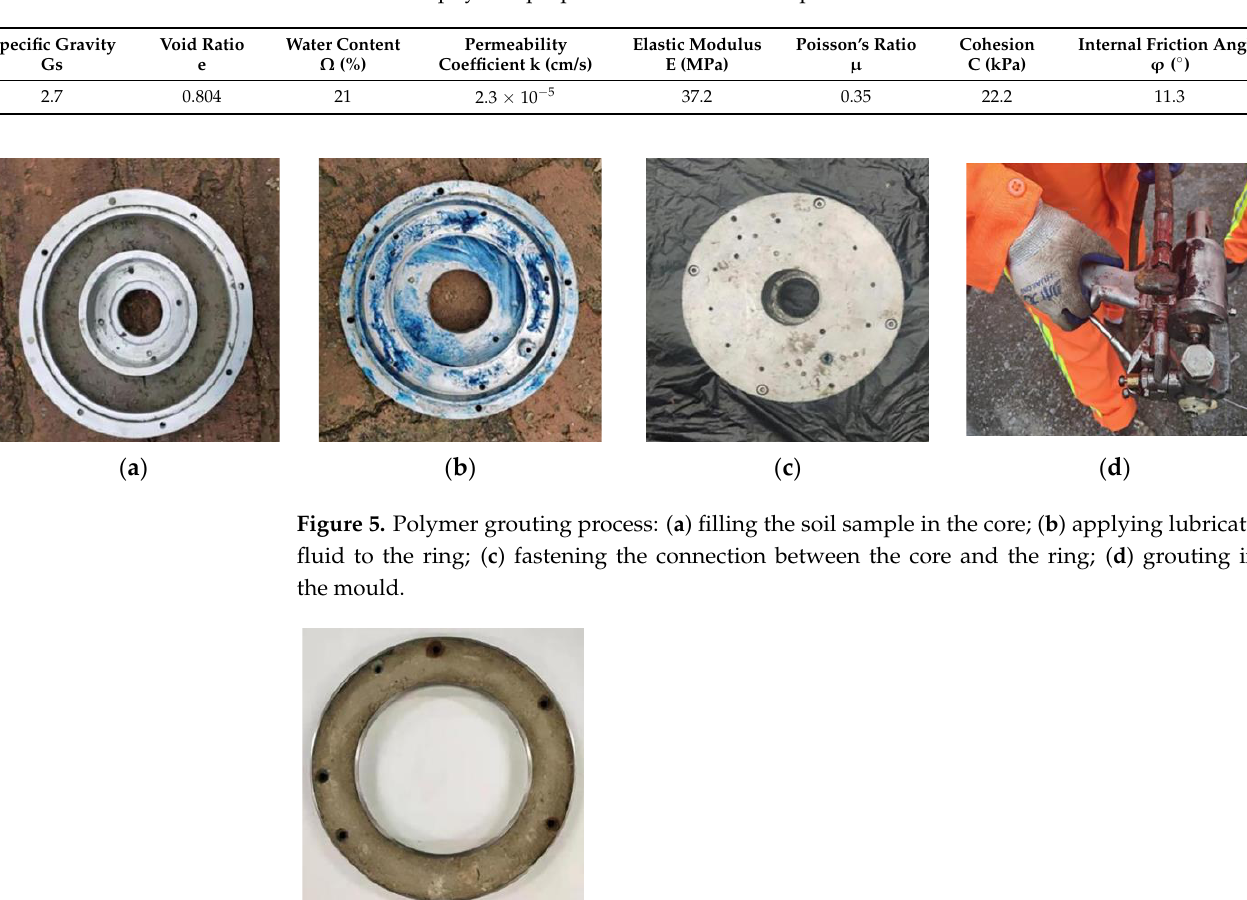
Table 3. Basic physical properties of soil used in experiment.